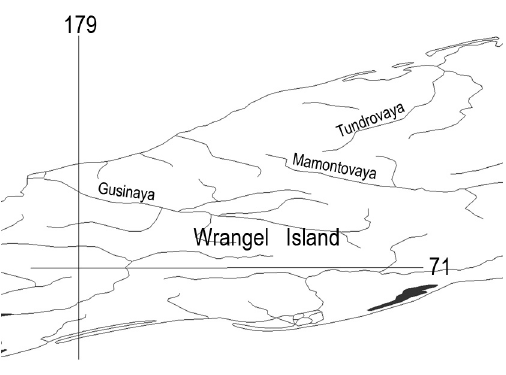
Fig. 26. Map of Basins of Mamontovaya and Tundrovaya Rivers calving grounds.